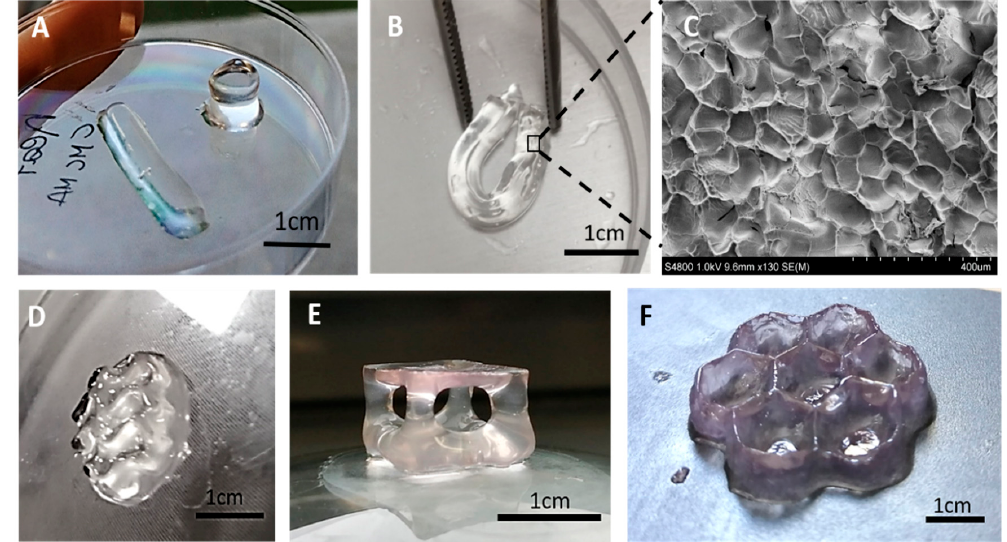
Figure 3. 3D-printed M-CMC hydrogels. ( A ) Simple cylinders and parallelepipeds (solvent: water). ( B ) The hydrogel exhibited good flexibility and handleability. ( C ) SEM analysis performed on the freeze-dried hydrogel. ( D – F ) 3D objects printed from water ( D ) and from culture medium solution ( E , F ).